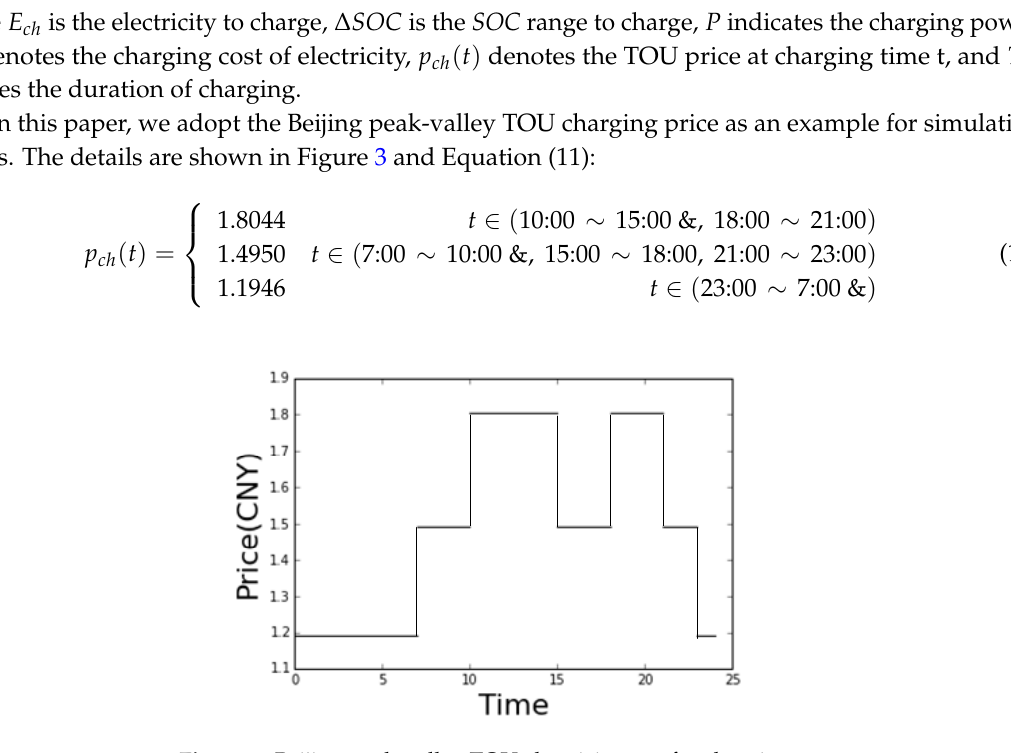
Figure 3. Beijing peak-valley TOU electricity rate for charging.